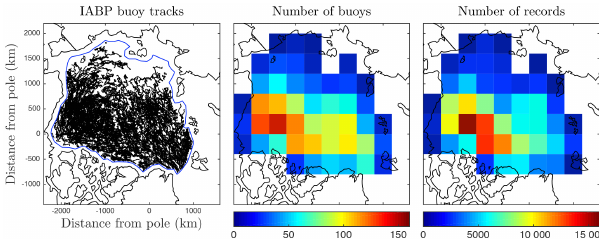
Figure 2. Buoy tracks from the IABP dataset for the winter peri- ods 1979–2011 (left panel) and the corresponding number of buoys (middle panel) and records (right panel). The central Arctic domain is delineated by a blue